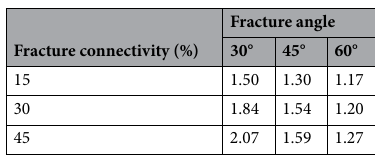
Table 8. Peak strain of the fractured soft rock: ε/ 10 − 2 .